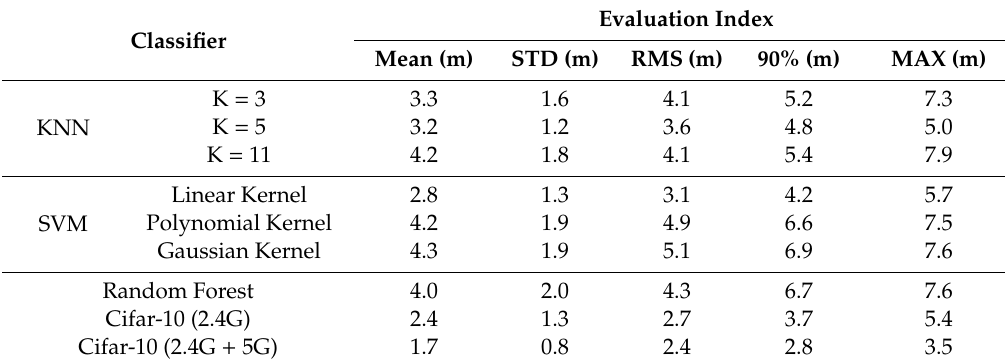
Table 3. Experimental test positioning